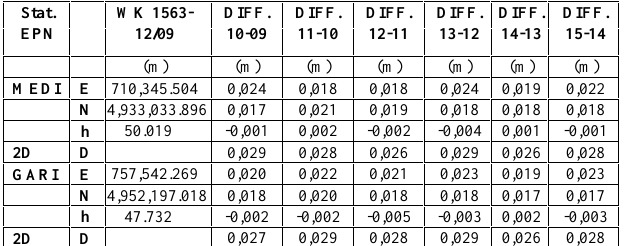
Table 2. Coordinate differences for Medicina and Porto Garibaldi Stations, 2009-2015, ITRF08 Datum.